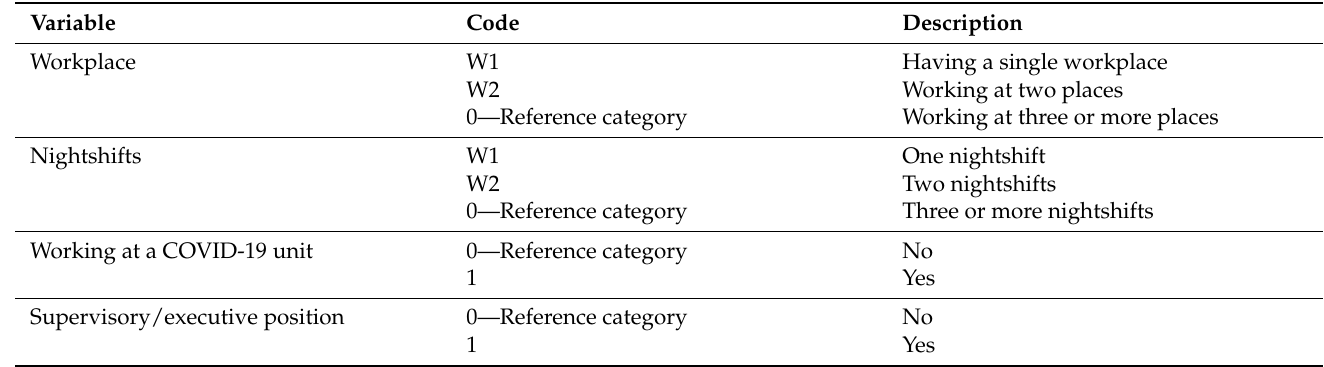
Table 3. Qualitative variable coding.